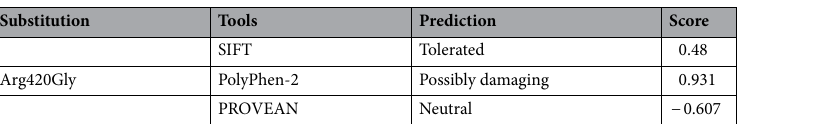
Table 4. Functional analysis of mutant c-kit protein (Arg420Gly) identified in acute myeloid leukemia patients (n =